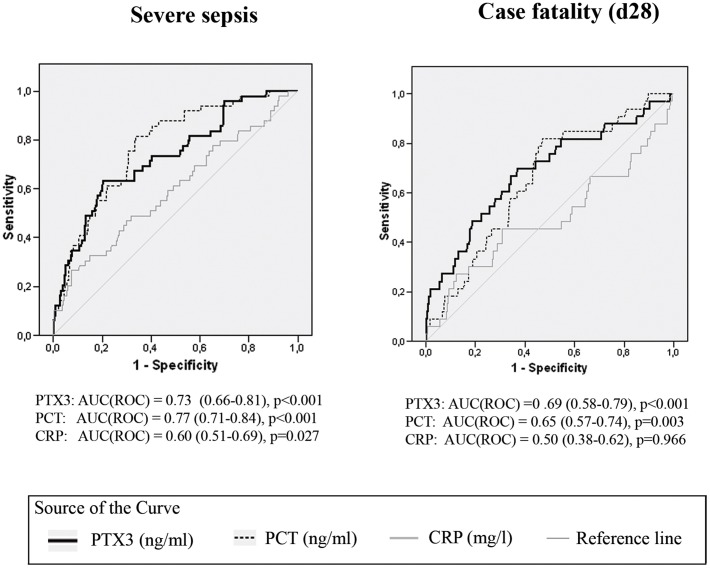
Receiver operating characteristic (ROC) curve for plasma levels of pentraxin 3 (PTX3), procalcitonin (PCT), interleukin-6 (IL-6) and C-reactive protein (CRP) detected on admission in relation to severe sepsis and case fatality (d28) in patients with suspected infection.AUC (ROC) (95% confidence interval, p<0.001.